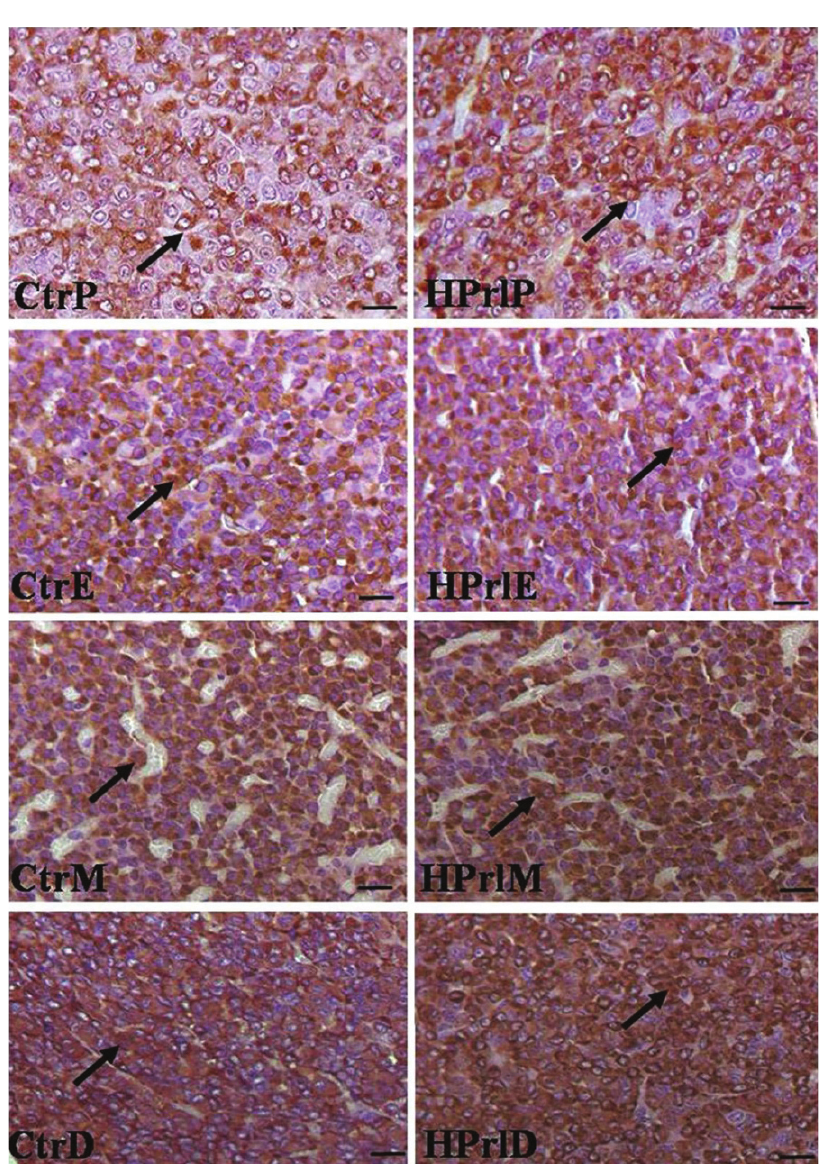
Fig. 1 - Immunohistochemical localization of prolactin in adenohypophyseal lactotrophs in female control (Ctr) mice or mice treated with metoclopramide (HPrl) in the estrous phase. Arrows indicate prolactin-positive cells. P= Proestrus; E= Estrus, M= Metaestrus; D= Diestrus. Scale bar =20 m